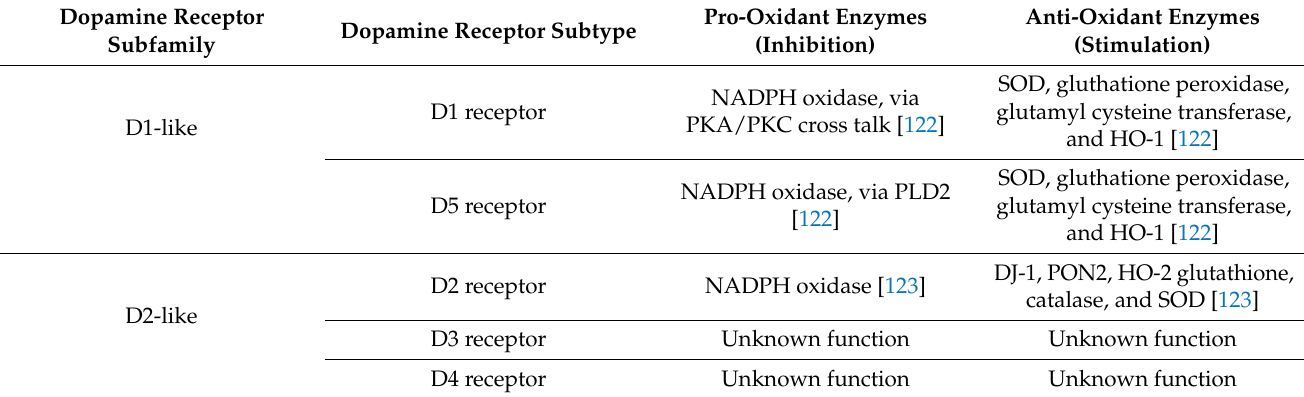
Table 3. Subtypes of dopamine receptors and their functions in redox